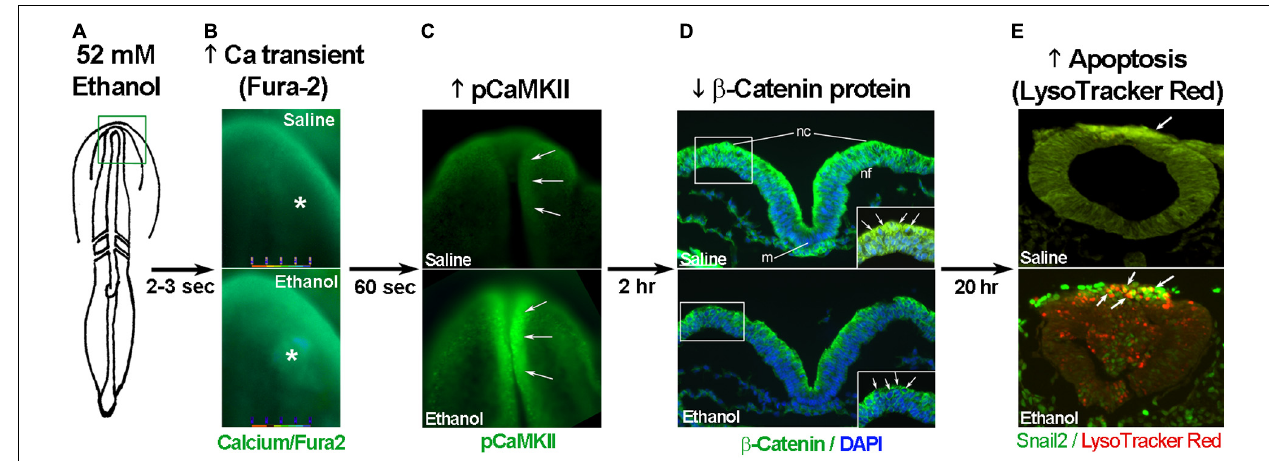
FIGURE 2 | Key events in ethanol-induced apoptosis of chick cranial neural crest. (A) Diagram of chick embryo having 3 somites (stage 8-). (B) Exposure to 52 mM ethanol instigates the mobilization of intracellular calcium stores (*) within the early headfold (boxed region) as quantified using Fura2. Shown is dorsal view with anterior to the top. (C) The calcium transient selectively activates CaMKII within the anterior neural folds including neural crest (arrows) as detected using antibody directed against phospho-CaMKII (green signal, arrows). A dorsal view of the headfolds is depicted, anterior to the top. (D) Among other targets, CaMKII phosphorylates and destabilizes β -catenin protein (green signal at green arrows in boxed region) within the